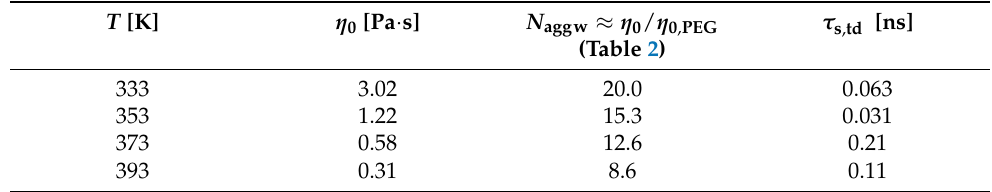
Table 4. Zero-shear viscosity η 0 , segmental relaxation time τ S,td and Rouse time τ R,td respectively for PEG-thy/dat at different temperatures. The ratio between the PEG-thy/dat viscosity, η 0 and PEG polymer viscosity, η 0, PEG values (presented in Table 2) yield the weight averaged number of aggregated building blocks N aggw